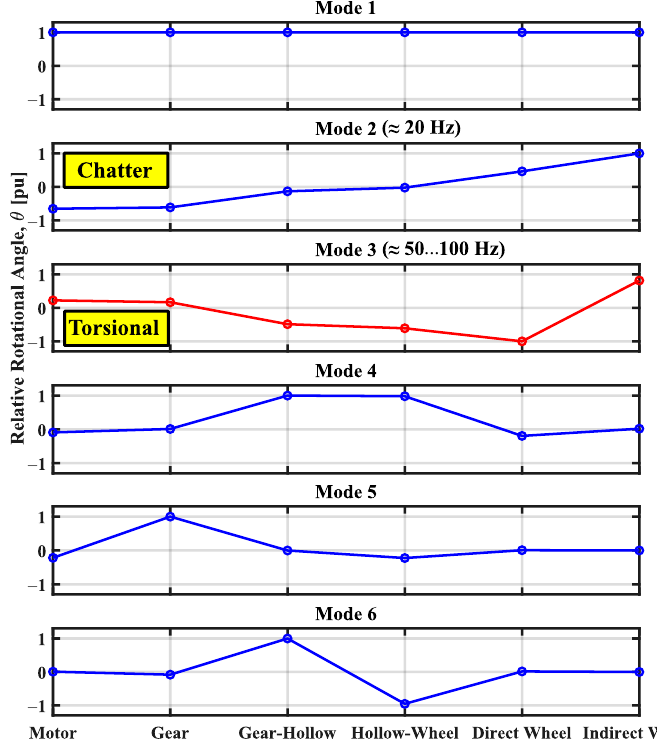
Figure 7. Mode shapes of the six-inertia model. The magnitude of the relative rotational angle is normalized based on the peak value at each